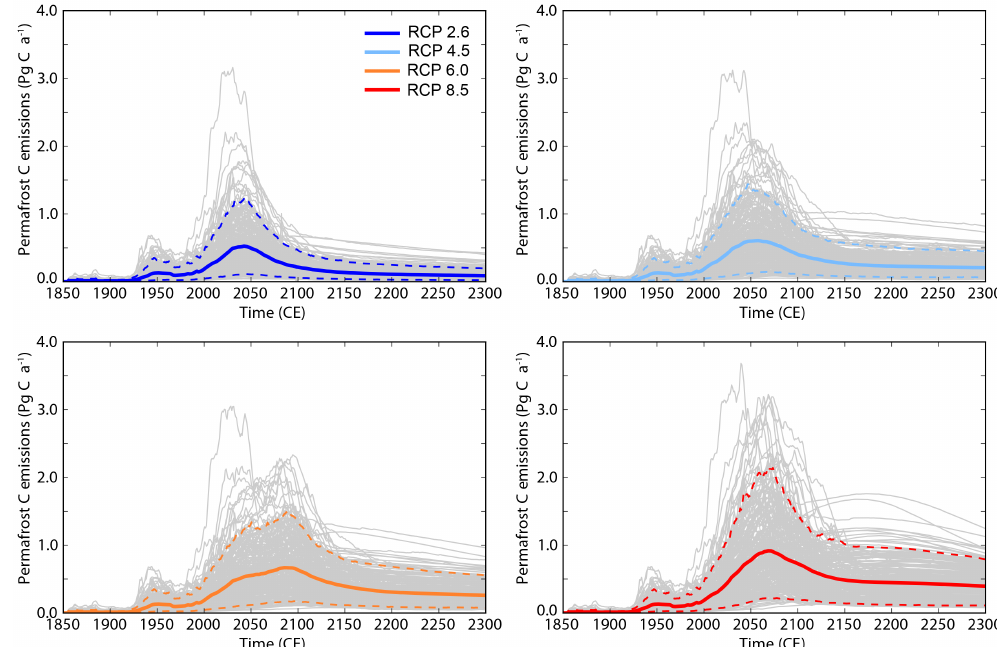
Figure 4. Emission of carbon from permafrost soils for each model variant (grey lines) and each RCP scenario. Mean for each scenario shown with think solid line. Fifth and 95th percentiles shown with dashed